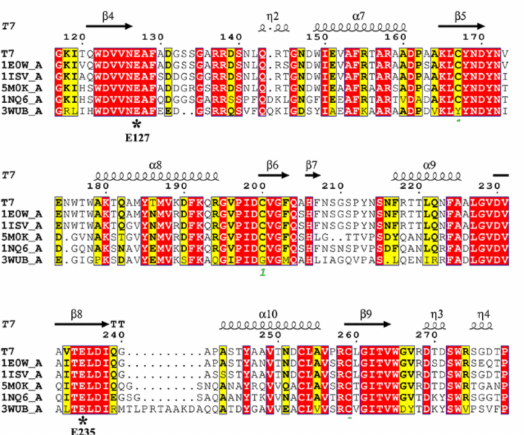
Figure 1. Amino acid sequence alignments of endo- β -1,4-xylanases using the online ClustalW tool. The species names are listed in the sequence alignment as follows: T7, XynST7 from Streptomyces sp. T7; IE0W_A, S. lividans ; 1ISV_A, S. olivaceoviridis E-86; 5M0K_A, Cellulomonas flavigena ; 1NQ6_A, S. halstedii JM8; 3WUB_A, Streptomyces sp. 9. The numbering of the amino acids starts at the N terminus of all sequences. Identical residues are shaded in red, while conserved residues are shaded in yellow. Arrows stand for β -strands, while helical curves denote α